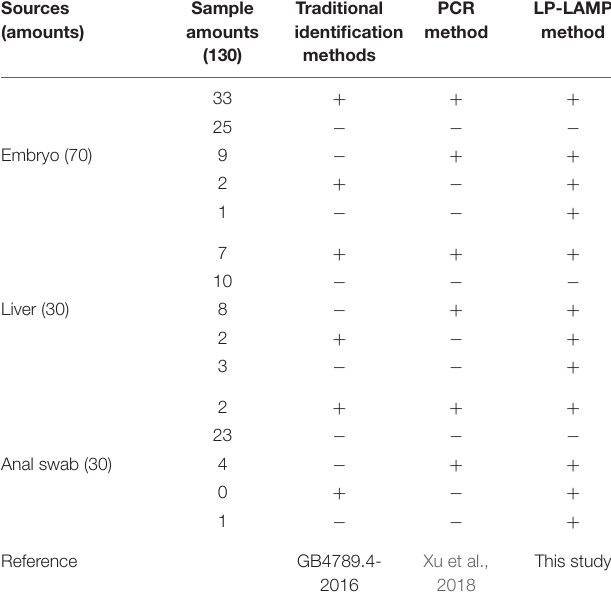
TABLE 3 | Comparison of the results of testing real samples using different